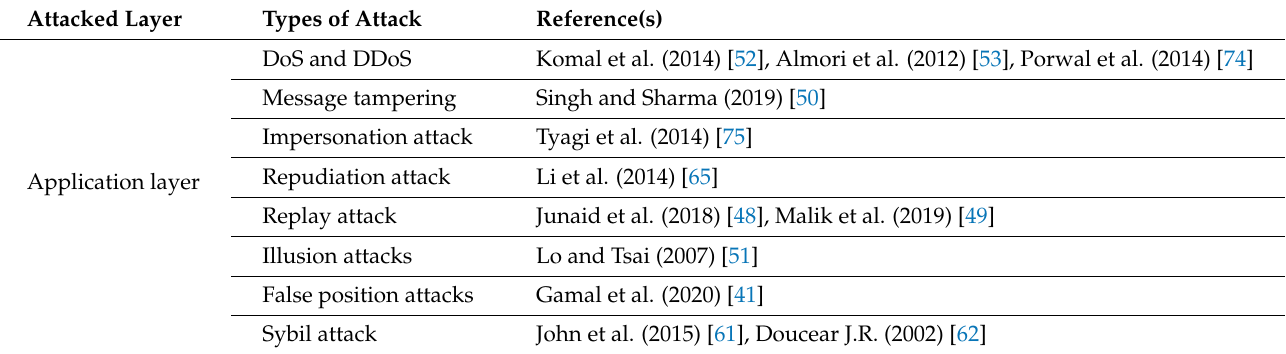
Table 2. Attack classification based on VANET